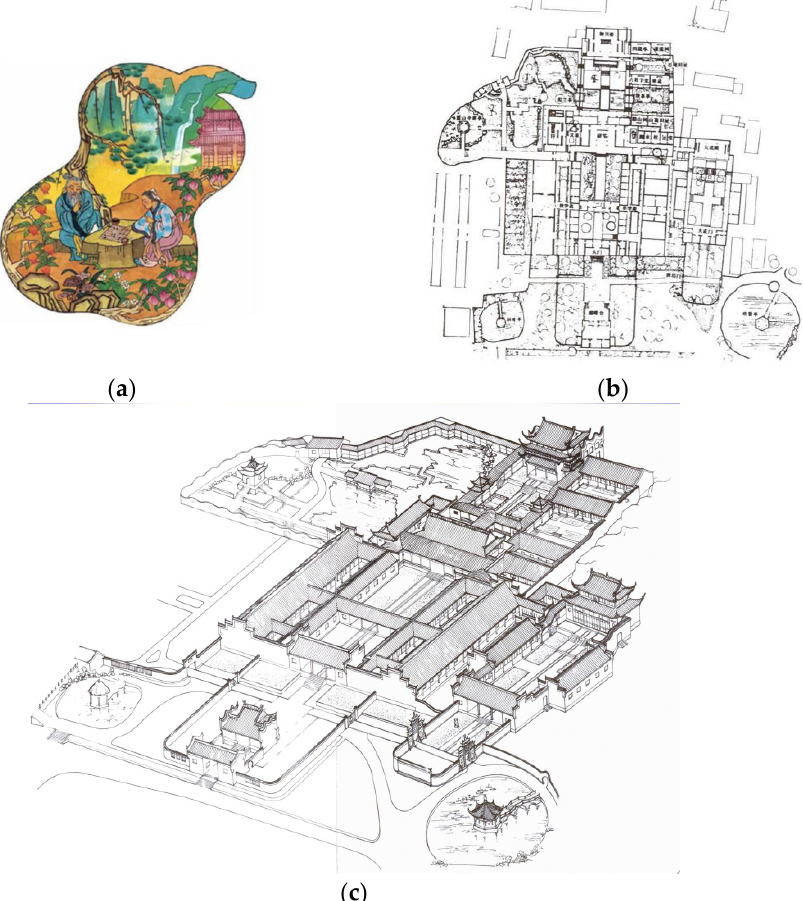
Figure 5. ( a ) The World in the Kettle (source: internet); ( b ) plan of Yuelu Academy (source: Archi- tecture and Culture of Yuelu Academy, Yang Shen-chou); ( c ) a bird's eye view of Yuelu Academy (source: Architecture and Culture of Yuelu Academy by Yang Shen-chou).